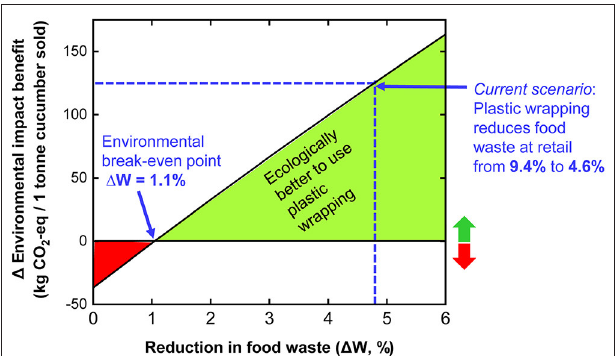
FIGURE 4 | Break-even analysis to indicate when the positive impact on climate change of food waste reduction due to plastic packaging surpasses the negative impact of additional plastic waste. The region shaded in green indicates when it makes sense to use packaging from an environmental perspective. The reduction in food waste ( 1 W, %) corresponds to the difference in food waste at retail between scenarios 1 and 2. The Y-axis reflects the corresponding difference in environmental impact. The current scenario is indicated by the dotted blue line, where plastic packaging of imported cucumbers lowers food waste at retail by an estimated 4.8%, with a net lower environmental impact of 125kg CO 2 -eq per tonne of cucumber sold at